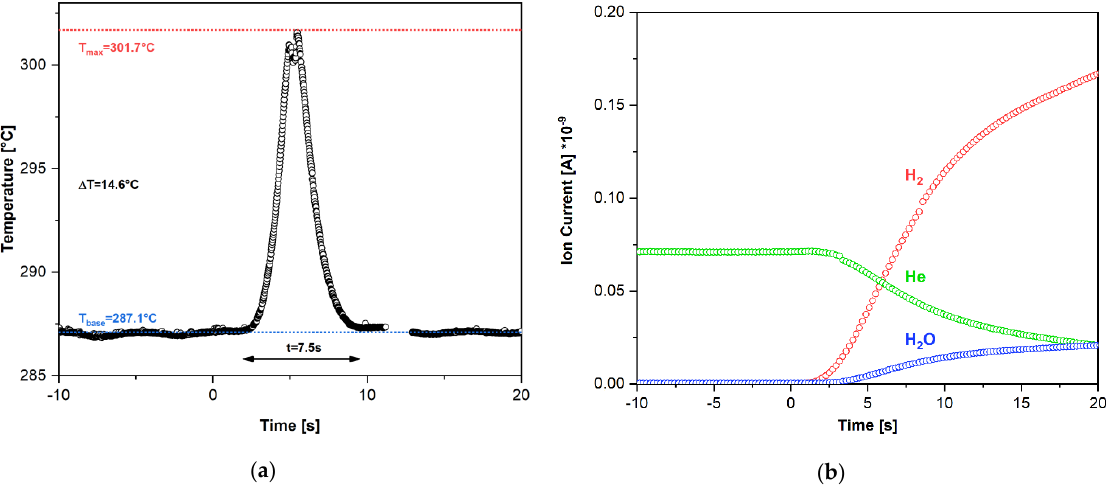
Figure 10. ( a ) The temperature profile recorded in the center of the reaction cell during the reduction of the oxidized 2% Ru/Al 2 O 3 in H 2 flow; ( b ) evolution of the MS spectra during the experiment. Experimental conditions: H 2 flow: 10 mL/min, P = 1 bar, baseline temperature = 287 °C.